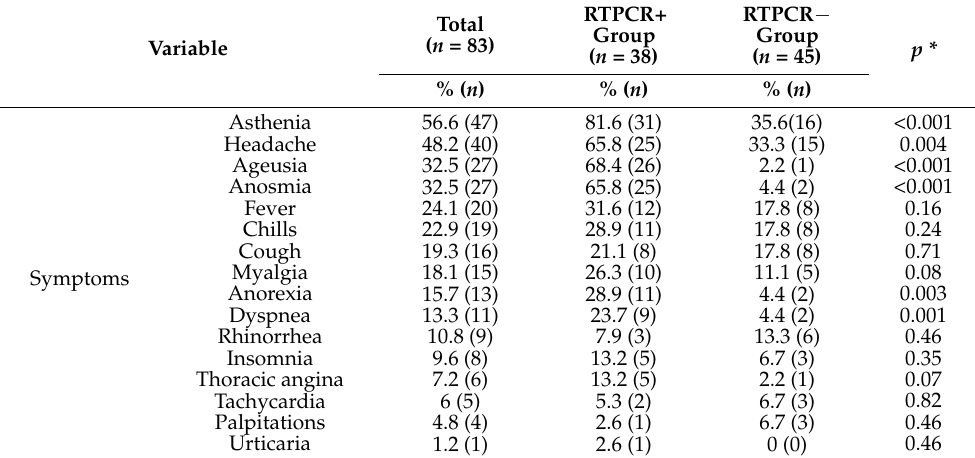
Most common clinical presentation and comparison between the RTPCR+ and RTPCR −